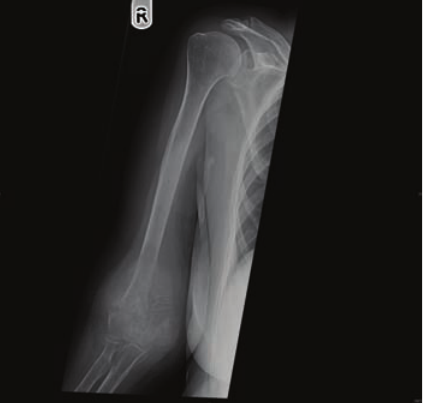
Figure 5: Plain radiograph of right arm showing aggressive bony lesion involving the distal metadiaphysis and epiphysis of the right humerus and associated with the sunburst periosteal reaction and pathological